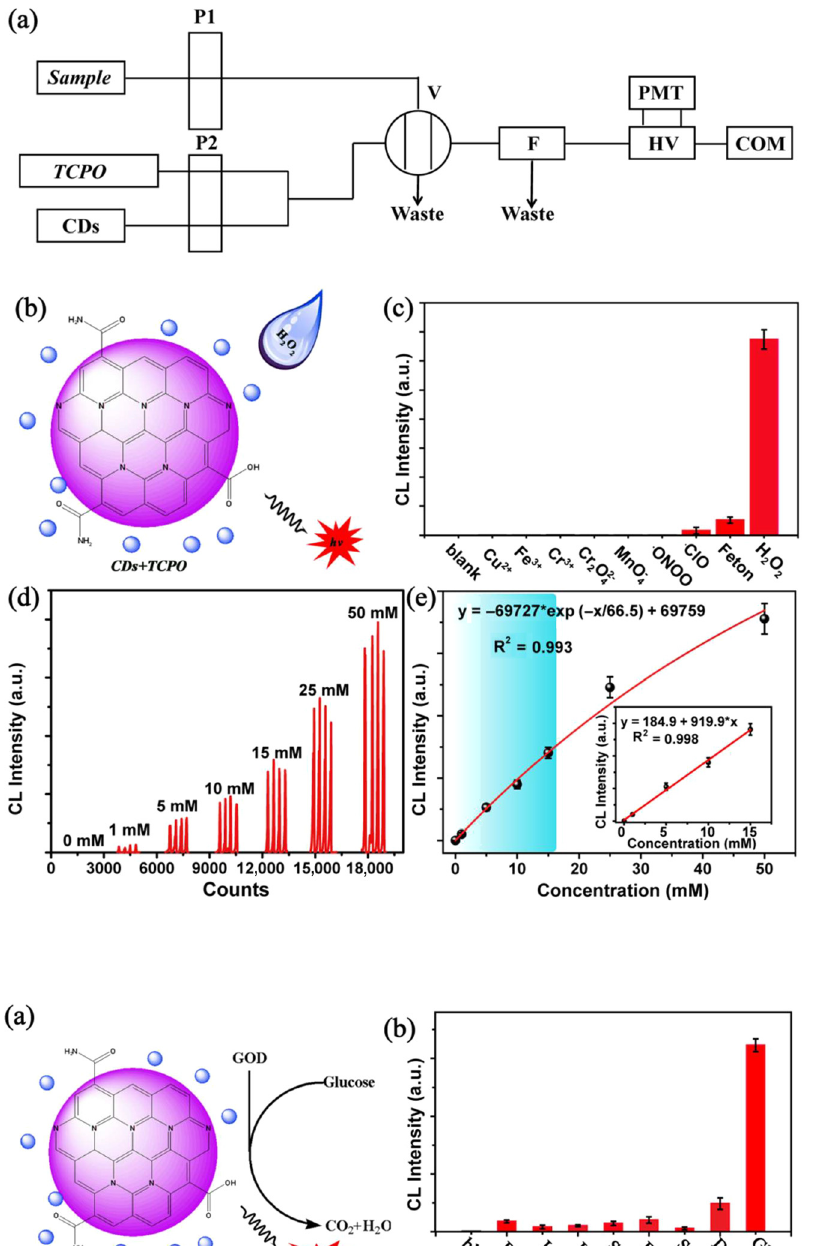
Figure 5: (a) Schematic illustration of the strategy for sensing glucose. (b) The selectivityofCLanalysisforglucose.(c)The CL signal curve for different concentration of glucose with 1.2 mg mL − 1 CDs solution and 10 mg mL − 1 TCPO solution. (d) The relationship between the maximum CL intensity and the concentration of glucose (insets: the linear range of the CL analysis for glucose), error bars represent the standard deviation for three